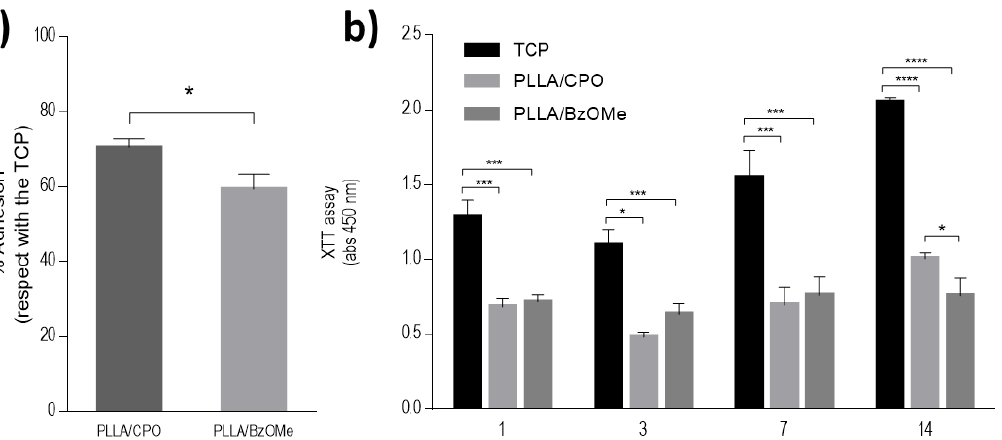
Figure 7. In vitro evaluation of PLLA/CPO and PLLA/BzOMe aerogels. ( a ) Cell adhesion after 24 h. Results show the percentage of adhesion with respect to the control (TCP). ( b ) Cell proliferation after 1, 3, 7, 14 days. (* p < 0.05; *** p < 0.01; **** p < 0.0001). SEM images of PDA-coated and uncoated PLLA/CPO aerogels are compared in Figure 8. The aerogel interconnected nanosheet structure, before coating, is shown in Figure 8a. In the coated sample, Figure 8b, a granular deposit of PDA onto the aerogel nanosheets is clearly detectable.